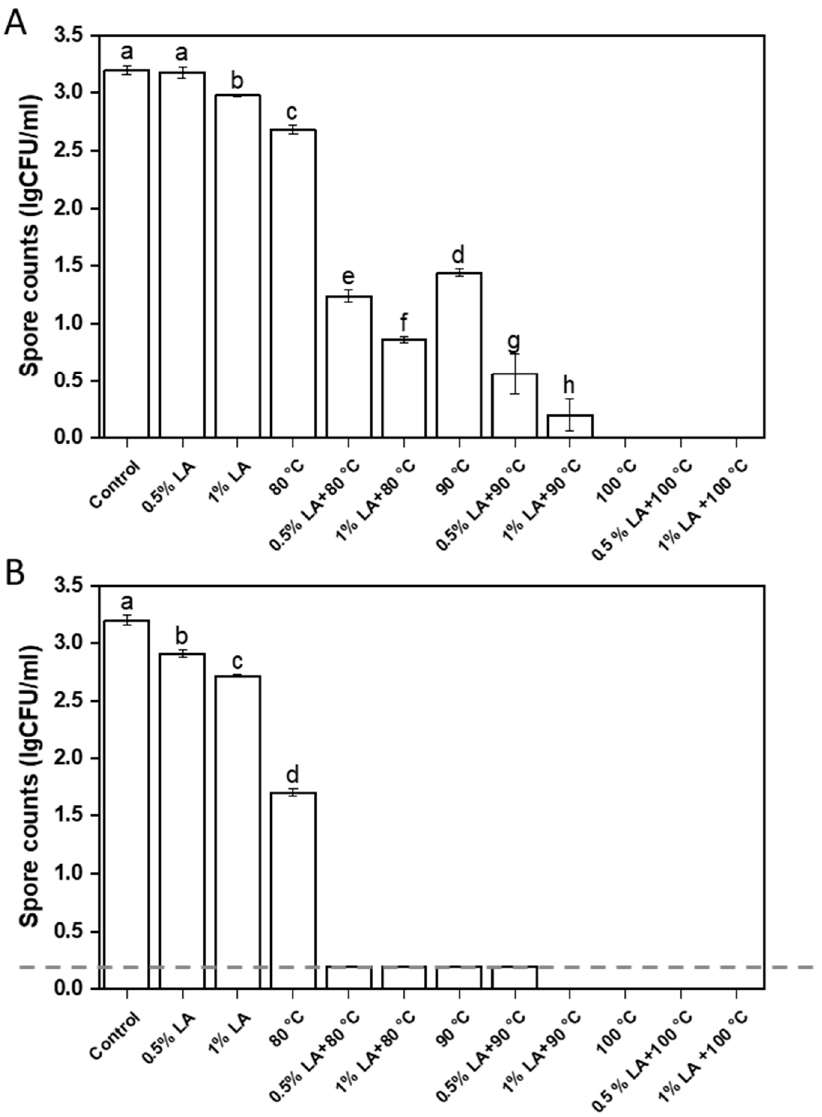
Figure 1. Counts of C. perfringens spores after different treatments for 30 min ( A ) and 60 min ( B ). Different lowercase letters indicated significant differences between treatments ( p < 0.05); <0.2 log CFU/mL indicated absence of bacteria on the TSC plate but indicated micro-turbidity in the access FTG.